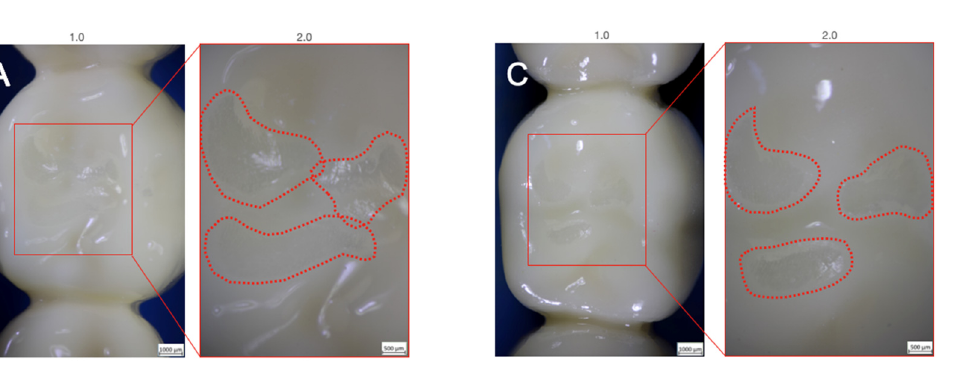
Figure 3. Superficial wear of glazing material for Groups Z-HT ( A ), Z-ST ( B ) and FL ( C ). Clear wear facets of Group RL ( D ) after cyclic loading. 3.2. Single Load to Failure Failure loads after static loading are summarized in Table 3 and graphically dis- played in Figure 4. Table 3. Descriptive statistics of failure load in [N]. Different superscript letters per column without (small letters) or with fatigue exposure (capital letters) indicate statistically significant differences ( p < 0.05) between materials. Results of t -tests ( t -value, p -value) show the effect of fatigue for each type of material (per row). Group